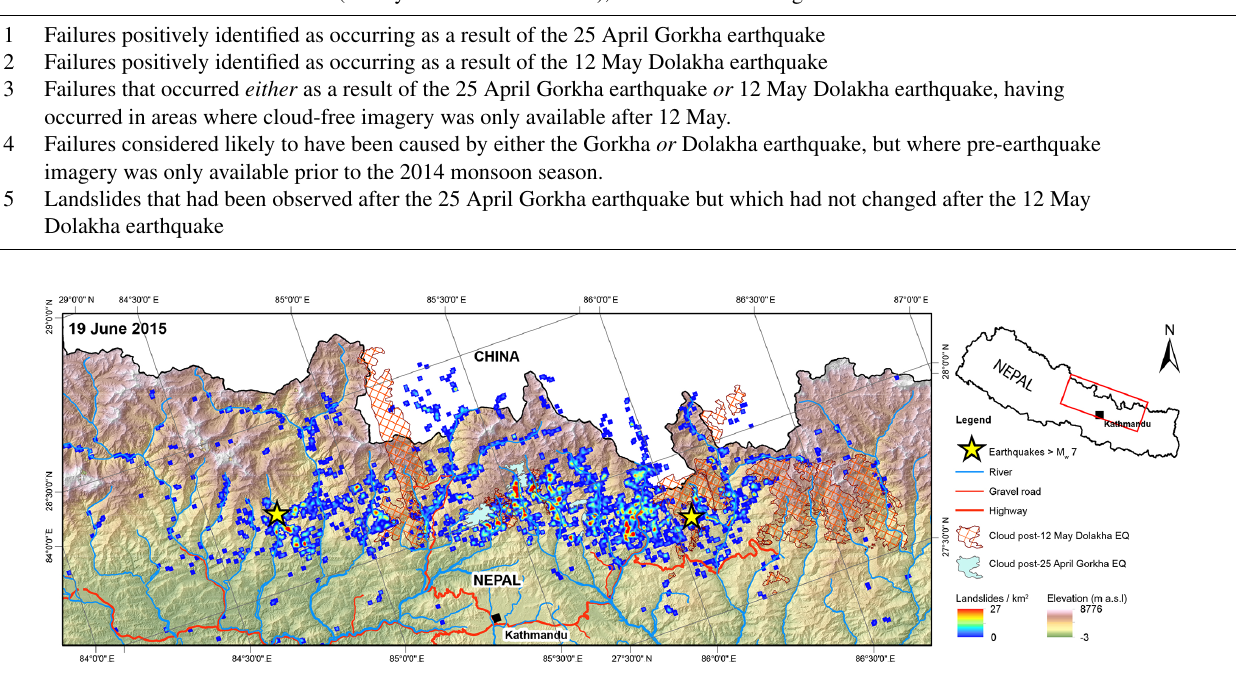
Figure 6. Extract from map released on 19 June 2015 containing landslide data from both earthquakes, comprising ∼ 4500 triggered by the Gorkha event, ∼ 300 by the Dolakha event, and ∼ 800 that could be attributed to either. Orange hatched pattern highlights areas that could not be mapped following the Dolakha earthquake event. Turquoise pattern (direct north of Kathmandu) highlight areas that remained unmapped following both